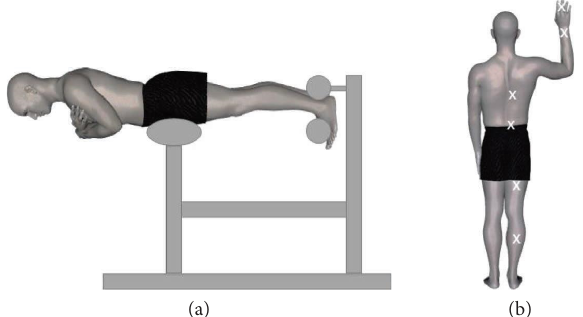
Figure 1: (a) Performance of the isometric fatiguing exercise (Sorensen test) on a roman chair. (b) Location of pressure-pain threshold assessment sites (note that the digit site was on the palmar surface of the